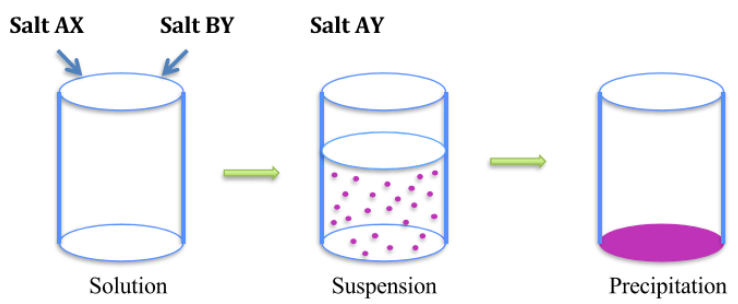
Figure 1. A simplified schematic representation of precipitation reaction [24]. AX(soluble) + BY(soluble) = AY(precipitate) +